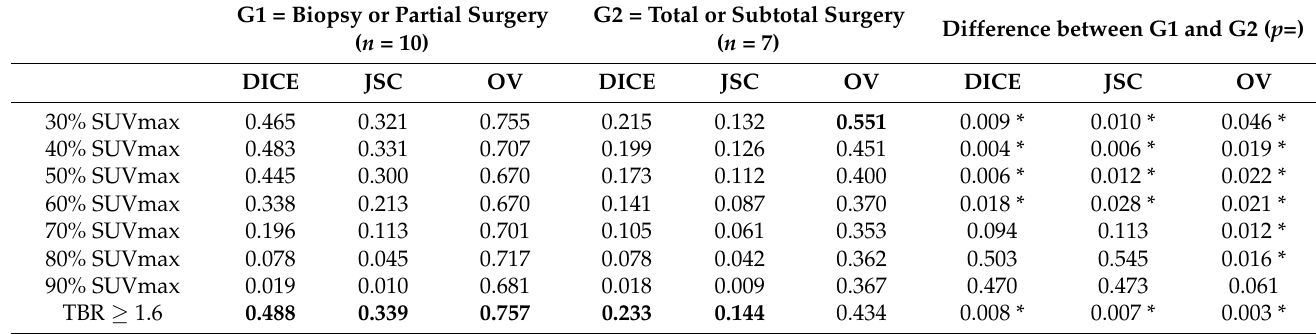
Table 4. Mean spatial similarity indices between MRI 3 according to different thresholds on pre- therapy PET (6 patients excluded for distant recurrence (out of field) without local recurrence). G1 = Biopsy or Partial Surgery